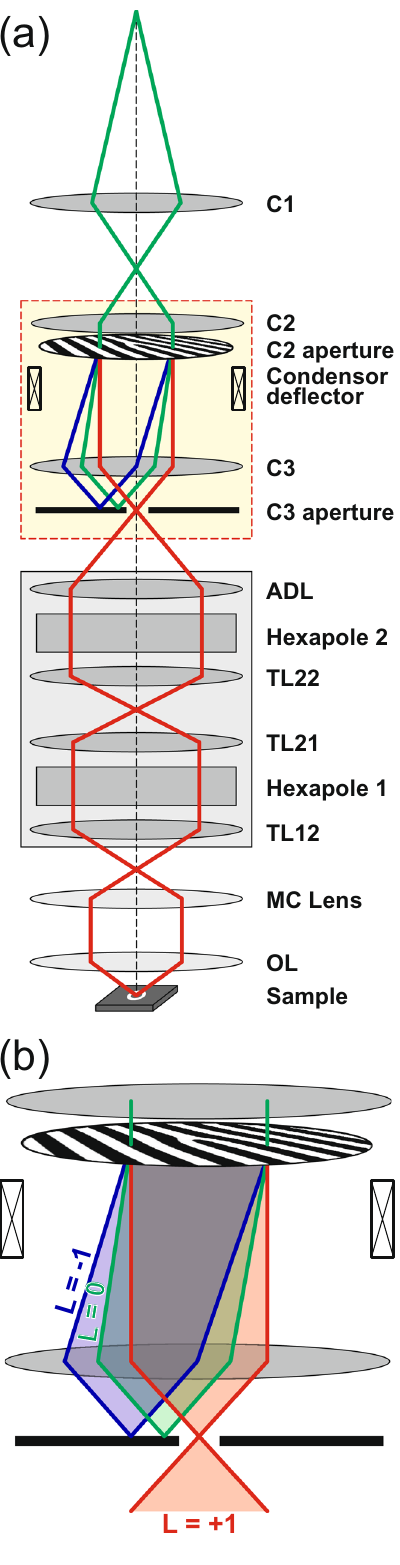
Figure 2. Electron optical setup for the generation of a switchable electron vortex state. ( a ) Schematic path of rays through the illumination lens system of the microscope. Here, Ci, ADL, TLxx, MC and OL denote the i th condenser lens, the adapter and transfer lenses of the probe corrector (grey box), the mini condensor, and the objective lenses, respectively. ( b ) Magnification of the section between the 2 nd (C2) and 3 rd (C3) condensor lens (marked by a yellow rectangle in a ), including the vortex aperture in the C2 aperture position. Blue, green, and red beams represent electron vortex beams with OAM of L = − 1, L = 0 and L = + 1,